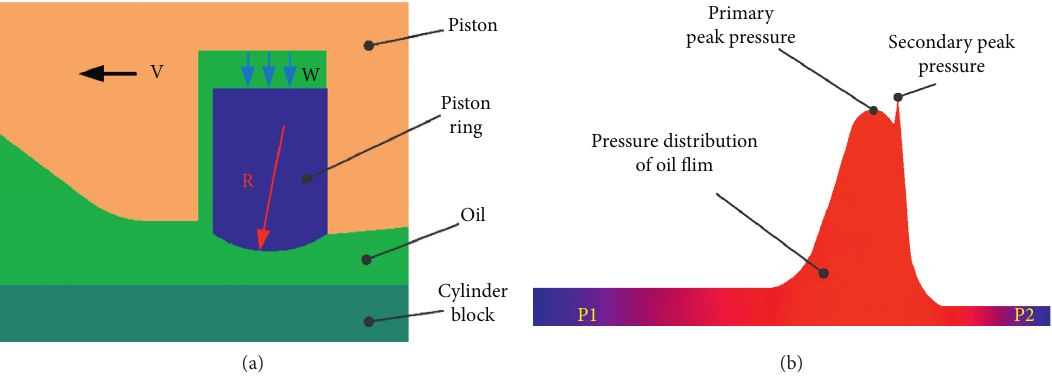
Figure 3: The analysis model of PRCB. (a) The configuration of PRCB; (b) the pressure distribution of